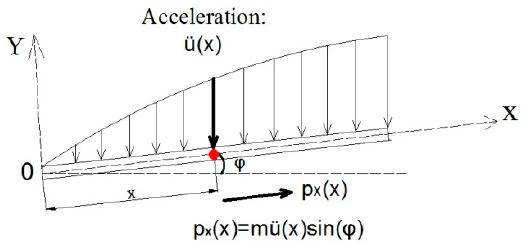
Figure 3. Acceleration distributed along the X-axis.